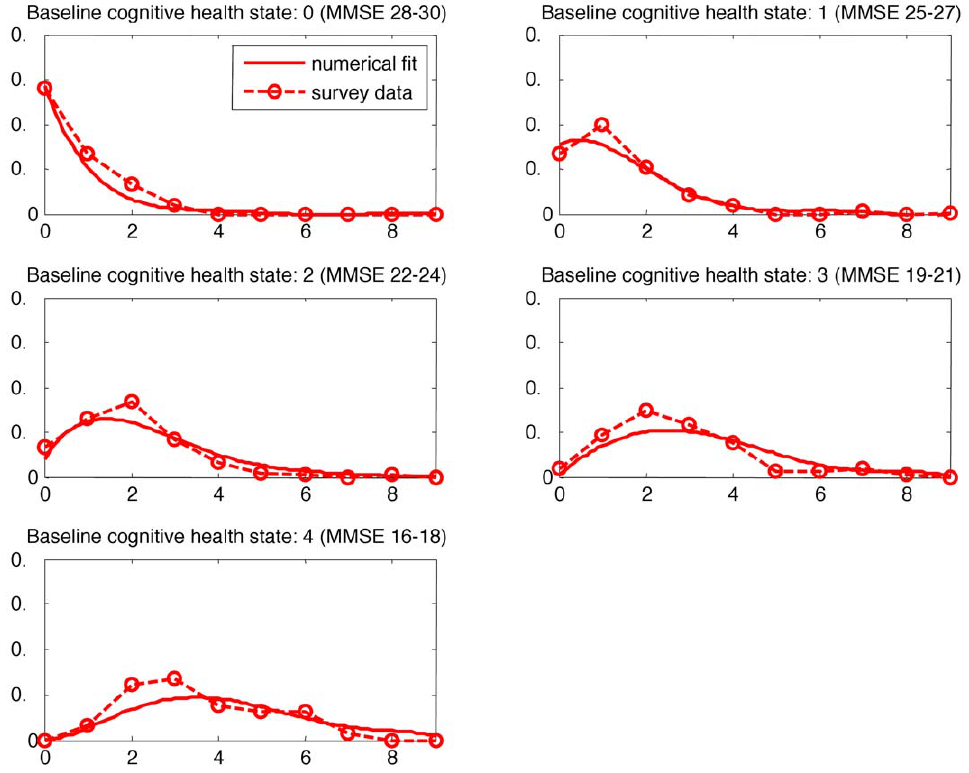
Figure 3. A graph showing change in cognitive health state (active group) at two years, by baseline health state. doi:10.1371/journal.pone.0011775.g003 Details of the modelling of the four year data and the corresponding graphs are available in Appendix S1 and Figures S1 and S2.